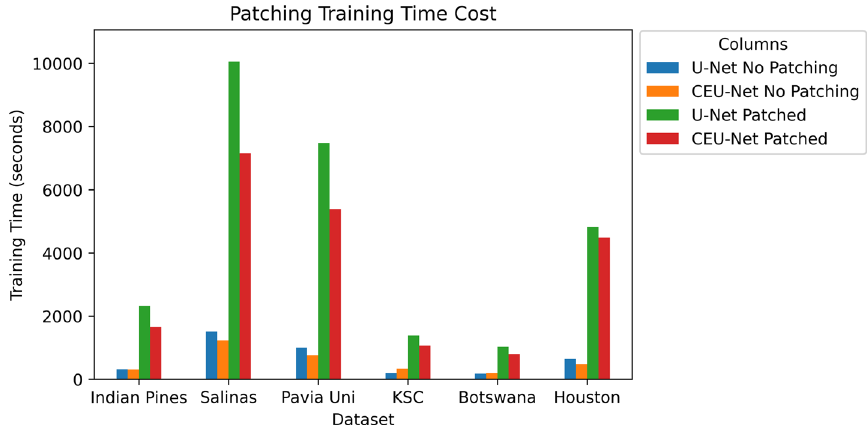
Fig. 5 Runtime analysis for single U-Net and CEU-Net for each dataset. The empirically optimal feature reduction technique was used before each semantic segmentation: PCA. Bands were reduced to 30. This figure shows the dramatic difference in runtime when employing patching. Patching greatly increases the runtime of semantic segmentation models. CPC was used with a patch size of 10 x 10